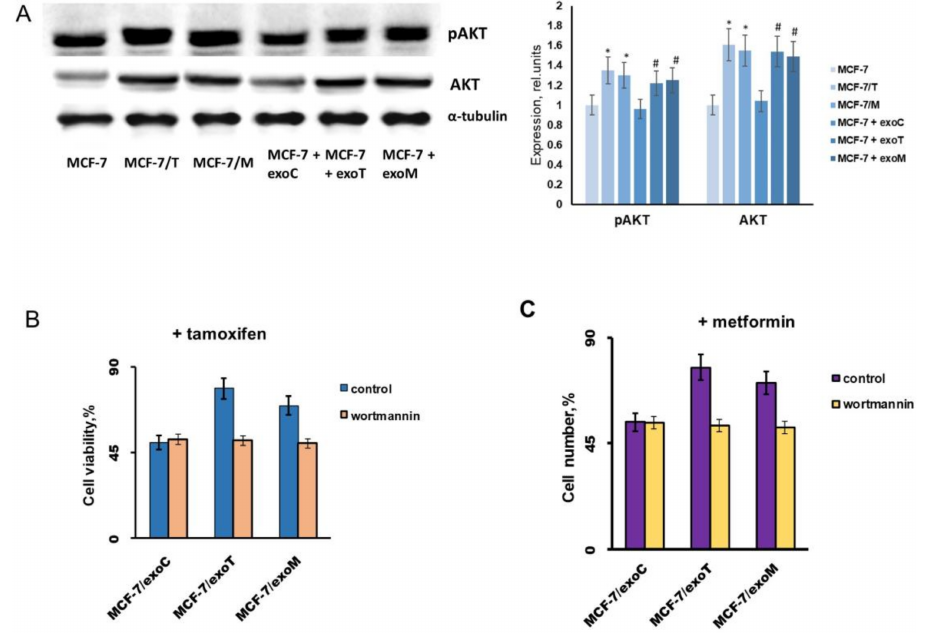
Figure 10. PI3K/Akt signaling and cell resistance. ( A ) Western blot analysis of pAkt and Akt in total cell extracts. The cell lines were similar to that in Figure 5. Protein loading was controlled by membrane hybridization with α -tubulin Abs. The blot represents the results of one of the three similar experiments. Densitometry was performed using ImageJ (NIH) software. * p < 0.05 versus MCF-7, # p < 0.05 versus MCF-7 + exoC. ( B , C ) Wortmannin influence on the exosome-mediated resistance. MCF-7 cells were treated with the control MCF-7 or “resistant” MCF-7/T and MCF-7/M exosomes within 14 days in the absence or presence 5 × 10 − 6 M wortmannin with subsequent determination of cell growth response to tamoxifen ( B ) or metformin ( C